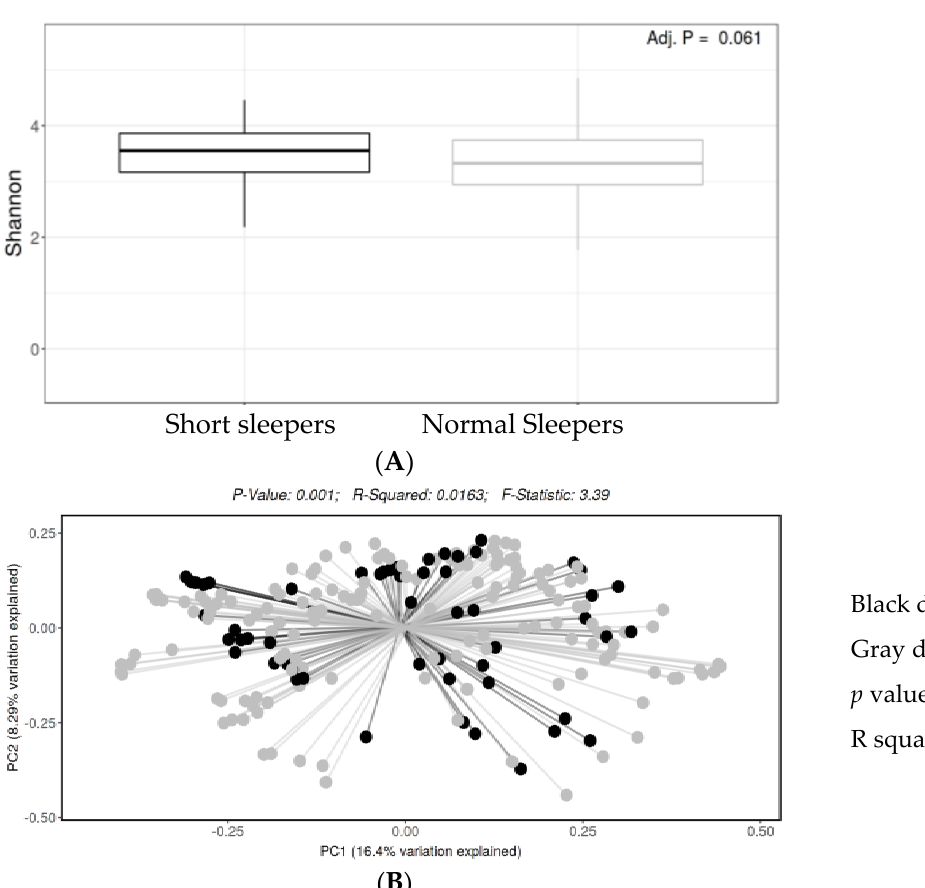
Figure 1. ( A ) Boxplot of the Shannon index (bacterial alpha diversity) by sleep hours (<6, short sleepers vs. 6–8, normal sleepers). There was no significant difference in bacterial richness and evenness (the Shannon index) ( q value = 0.061, Kruskal–Wallis test) between the two groups. ( B ) Principal coordinate analysis (PCoA) with weighted Bray–Curtis dissimilarity shows the bacterial beta diversity differed significantly between the two groups ( p value = 0.0001, PERMANOVA test). The centroids of the two groups did not overlap. The fraction of diversity captured by the coordinate was shown as a percentage in the corresponding axis. PC1 and PC2 represent the top two principal coordinates that capture most of the diversity.